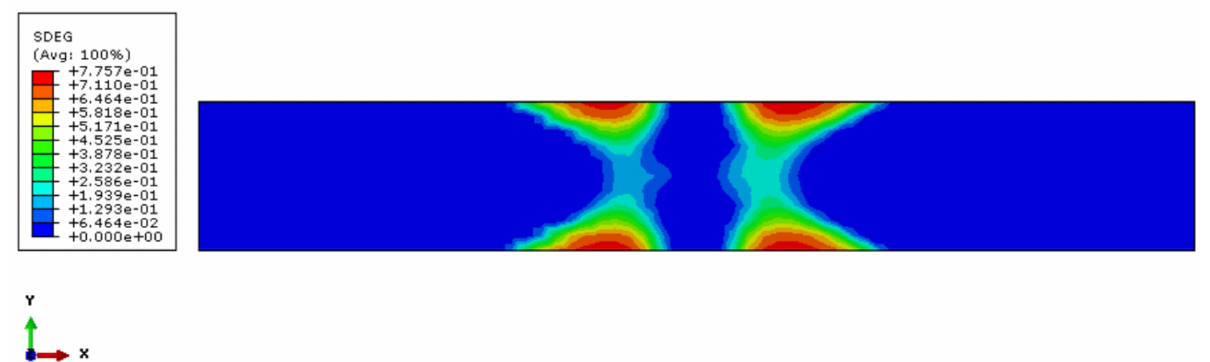
Figure 14. Distribution of damage variable fields on the PyC